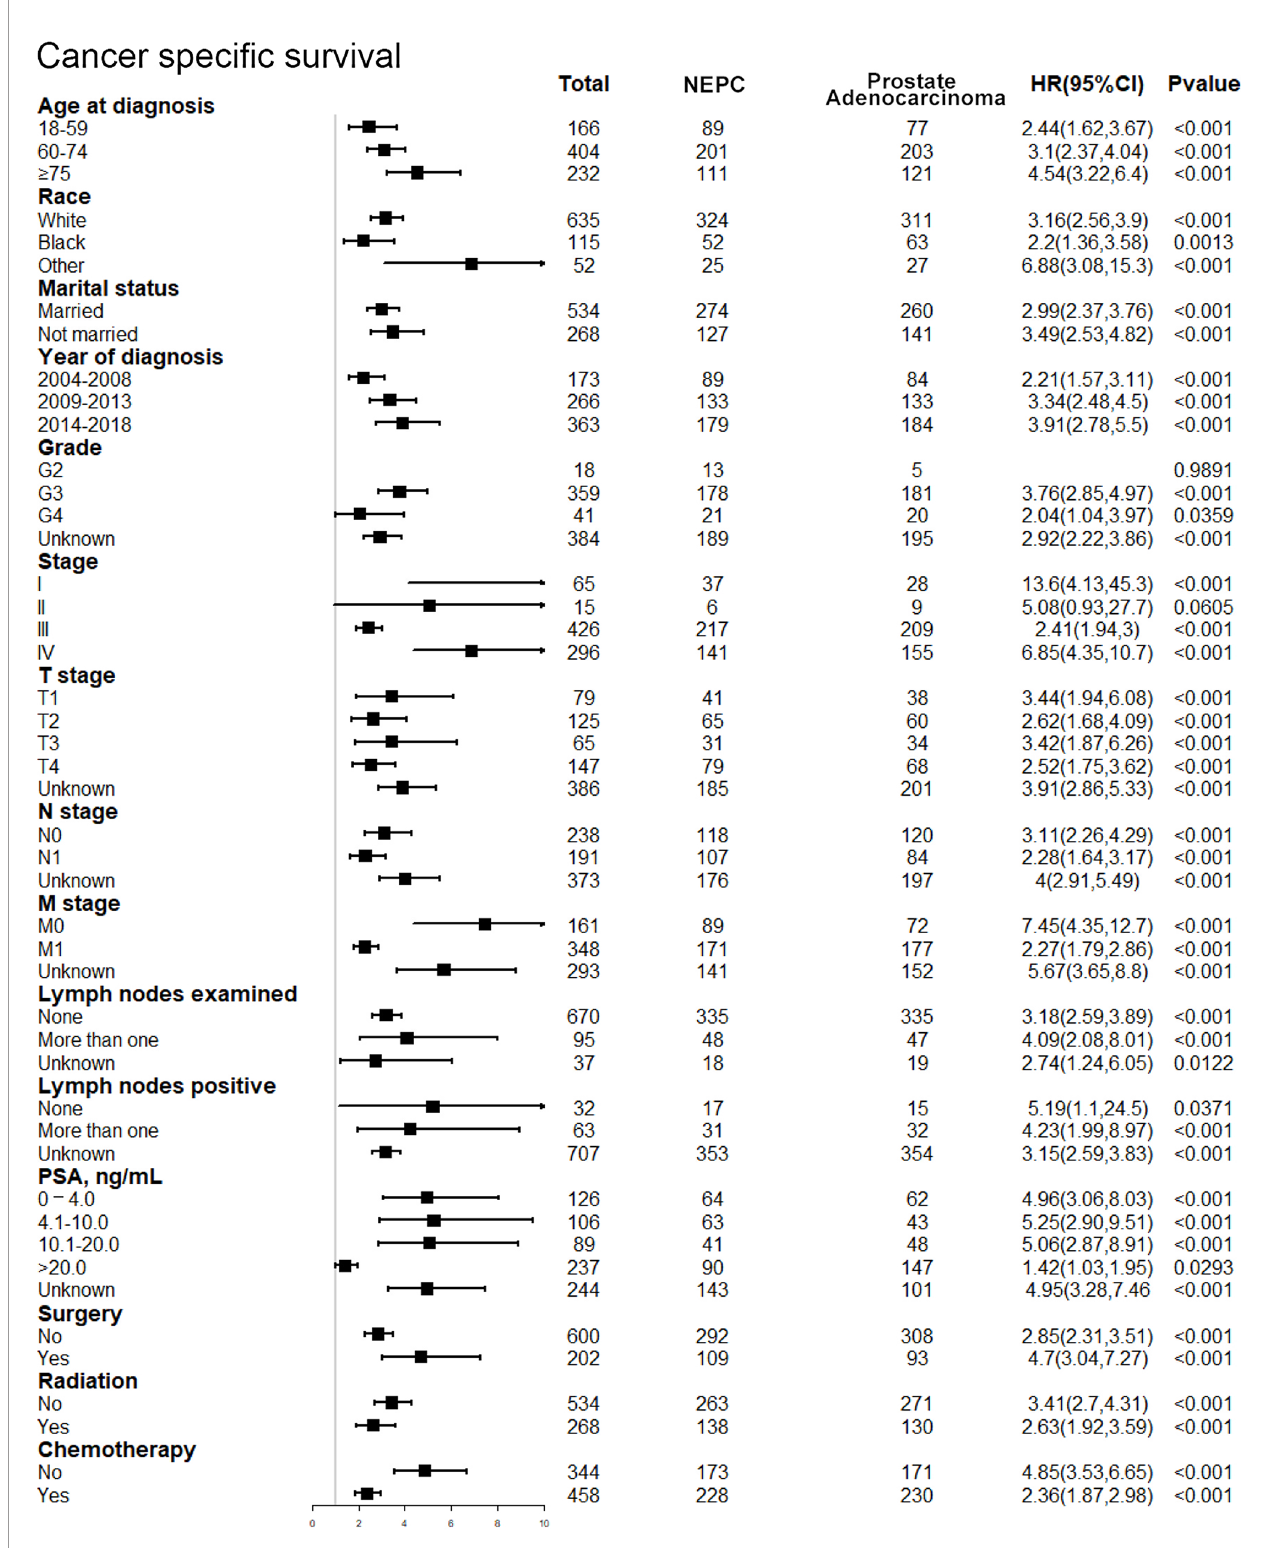
FIGURE 4 | Forest plot of the subgroup analysis for NEPC and prostate adenocarcinoma in CSS. NEPC, neuroendocrine prostate cancer; CSS, cancer-speci fi c survival.